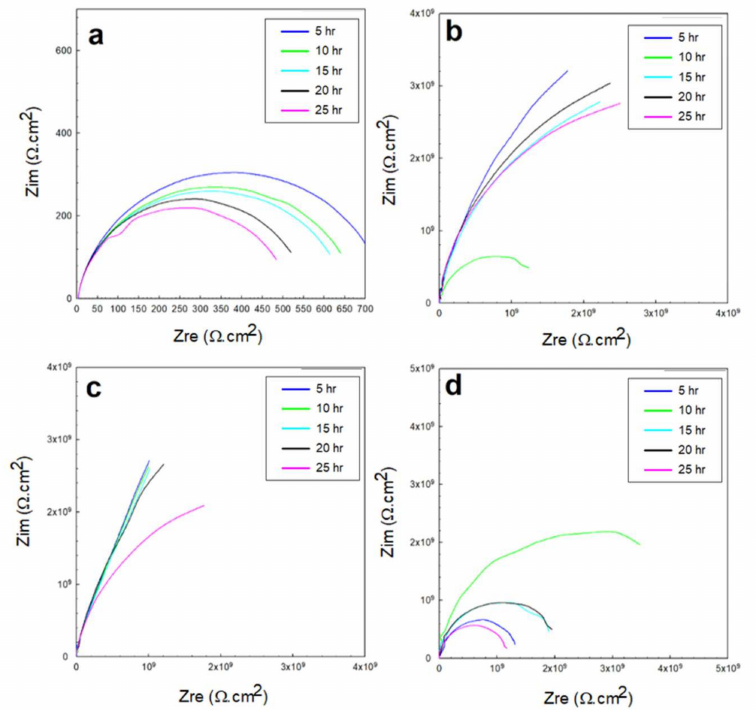
Figure 10. EIS Nyquist plots of the 0.5 M HCl solution for: ( a ) exposed steel, ( b ) glass/epoxy, ( c ) Kevlar/epoxy, and ( d ) epoxy